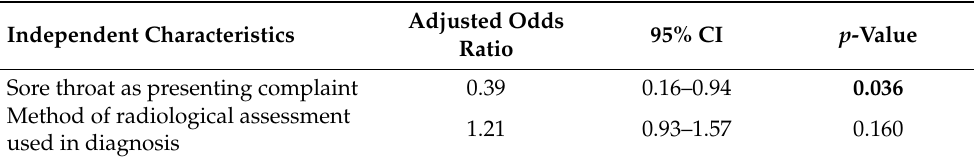
Table 3. Multiple logistic regression between independent variables that showed statistically signifi- cant association with STG compliance.